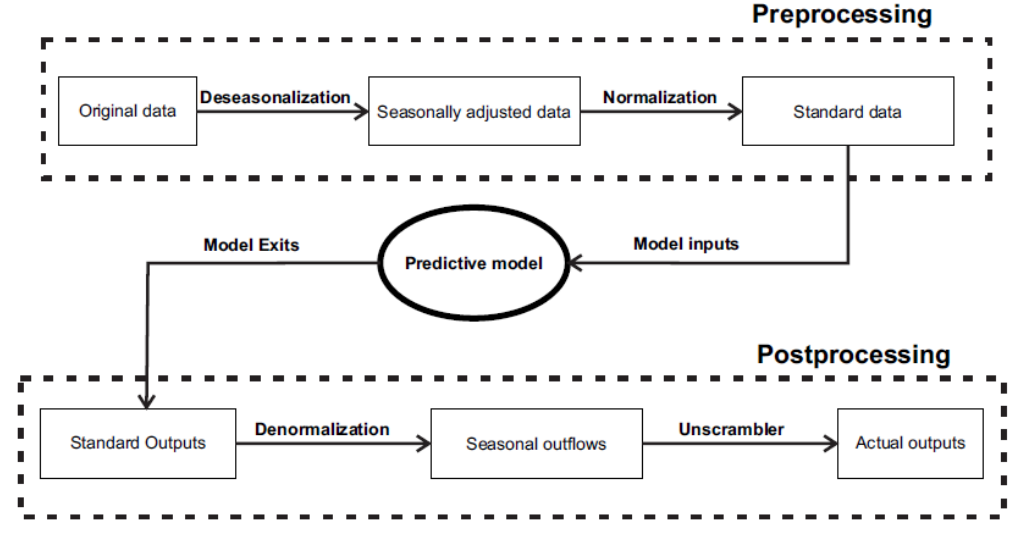
Figure 5. Preprocessing and postprocessing stages.